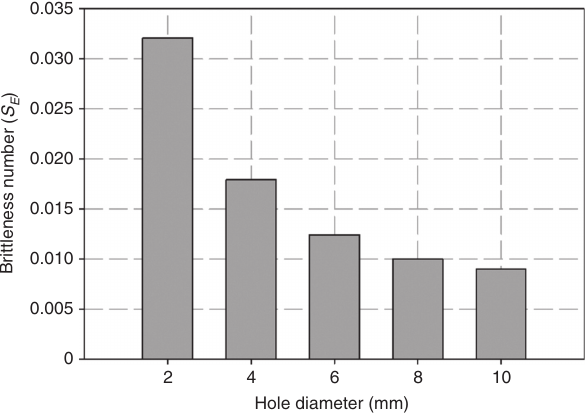
Figure 8 Specimen size effect on brittleness number for [0/90]